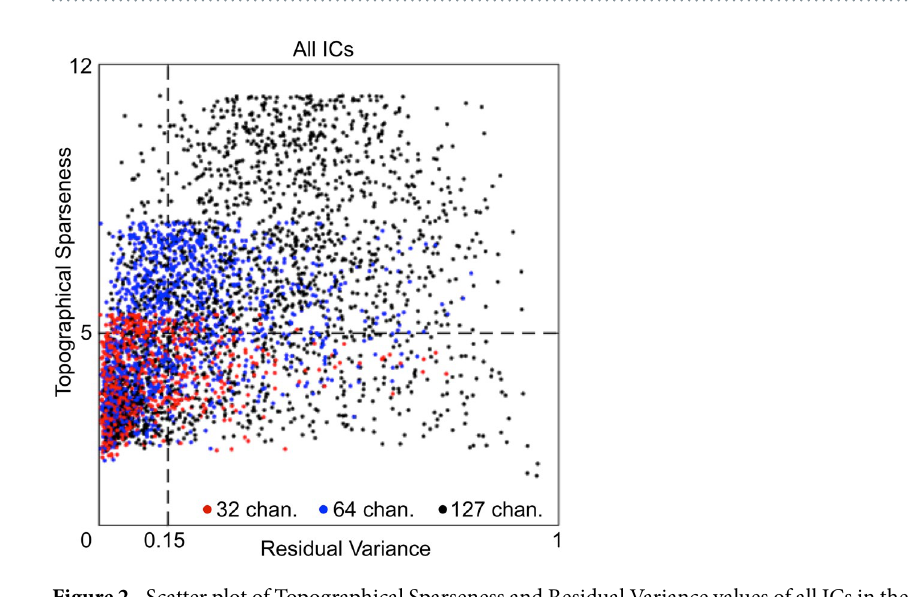
Figure 1. Examples of ( A , B and D ) artefact ICs which were excluded and ( C ) a good IC kept for further analysis. The black dots are positions of channels in the 64-channel EEG system. Colour-coding indicates projection weights of an IC (column of the inverse weight matrix, EEG.icawinv in EEGLAB). Panels A and B demonstrate ICs with topographical sparseness (TS) > 5, that were excluded from further analysis. Panels B and D demonstrate ICs with residual variance (RV) of the equivalent dipoles exceeding 15%. These ICs were also excluded from further analysis. Panel C demonstrates an IC which was kept for further analysis (TS > 5 and RV < 15%).